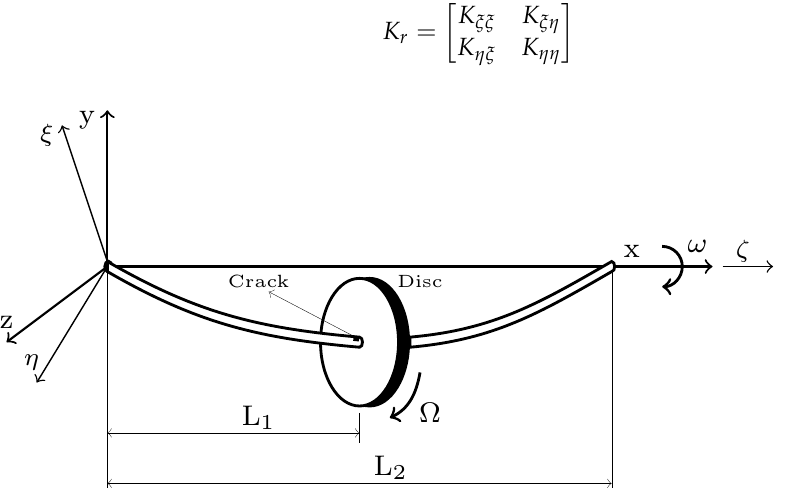
Figure 1. A Jeffcott rotor model with a single crack near the disc in the stationary coordinate ( x , y , z ) and rotating coordinate ( ζ , ξ , η ) frames.